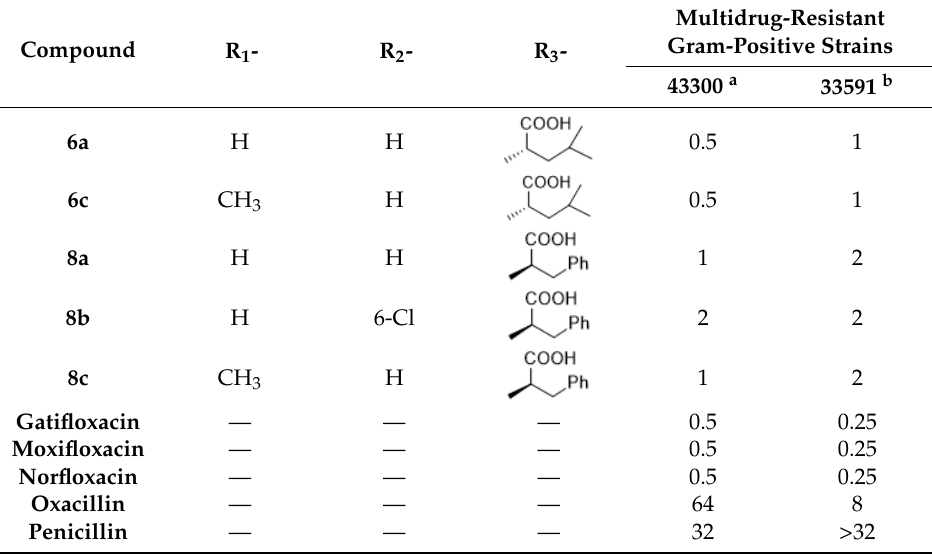
Table 2. Inhibitory activity (MIC, µ g/mL) of compounds 6a , 6c and 8a – c against clinical isolates of multidrug-resistant strains. Table 2. Inhibitory activity (MIC, µg/mL) of compounds 6a , 6c and 8a-c against clinical isolates of Table 2. Inhibitory activity (MIC, µg/mL) of compounds 6a , 6c and 8a-c against clinical isolates of Table 2. Inhibitory activity (MIC, µg/mL) of compounds 6a , 6c and 8a-c against clinical isolates of Table 2. Inhibitory activity (MIC, µg/mL) of compounds 6a , 6c and 8a-c against clinical isolates of Table 2. Inhibitory activity (MIC, µg/mL) of compounds 6a , 6c and 8a-c against clinical isolates of multidrug-resistant strains. multidrug-resistant strains. multidrug-resistant strains. multidrug-resistant strains. multidrug-resistant strains.